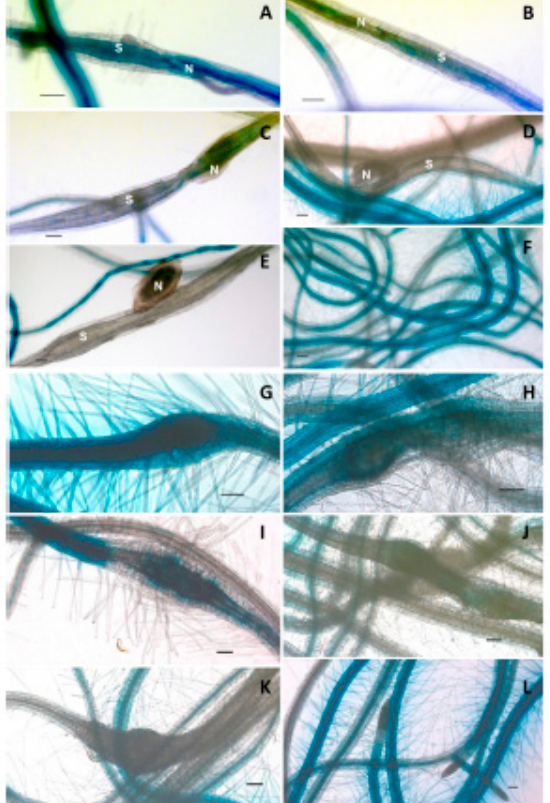
Figure 6. Promoter::GUS analysis of LTPg5 in syncytia and galls induced by H. schachtii and M. incognita, respectively, at di ff erent time points. ( A – F ) represent GUS staining in 3, 5, 10, 12, and 15 dpi syncytia and uninfected roots, respectively, where N = nematode and S = syncytia. Similarly, ( G – L ) represent GUS staining in 3, 5, 10, 12, and 15 dpi galls and uninfected roots, respectively. Scale bar = 100 µm.